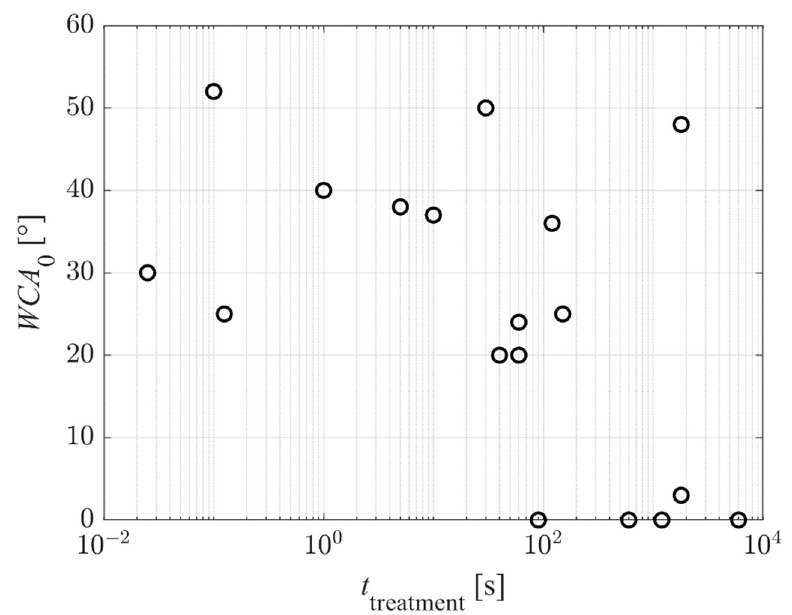
Figure 9. The WCA of as-treated PET samples (no aging) versus the plasma treatment time.